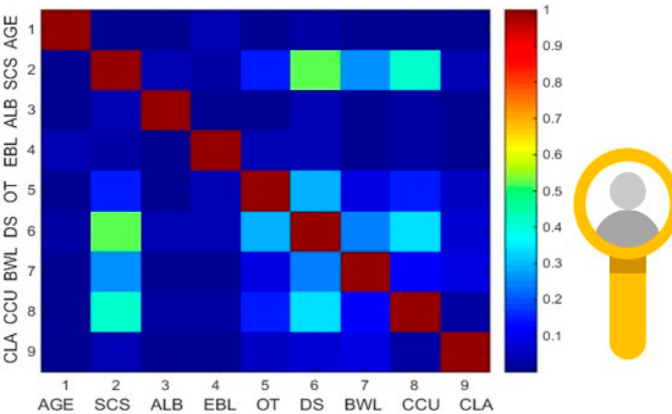
Figure 3. Correlation heatmap showing the pairwise associations between the variables selected for the calibration model (significant variables with p < 0.05). The association between the continuous variables was examined using Pearson’s correlation. The highest correlation was observed between SCS and DS. SCS = Surgical Complexity Score; ALB = Pre-Surgery Albumin; EBL = Estimated blood loss; OT = Operative time; DS = Disease Score; BWL = Bowel Resection; CCU = CCU Admission; CLA = Clavien Dindo complication 3–5.